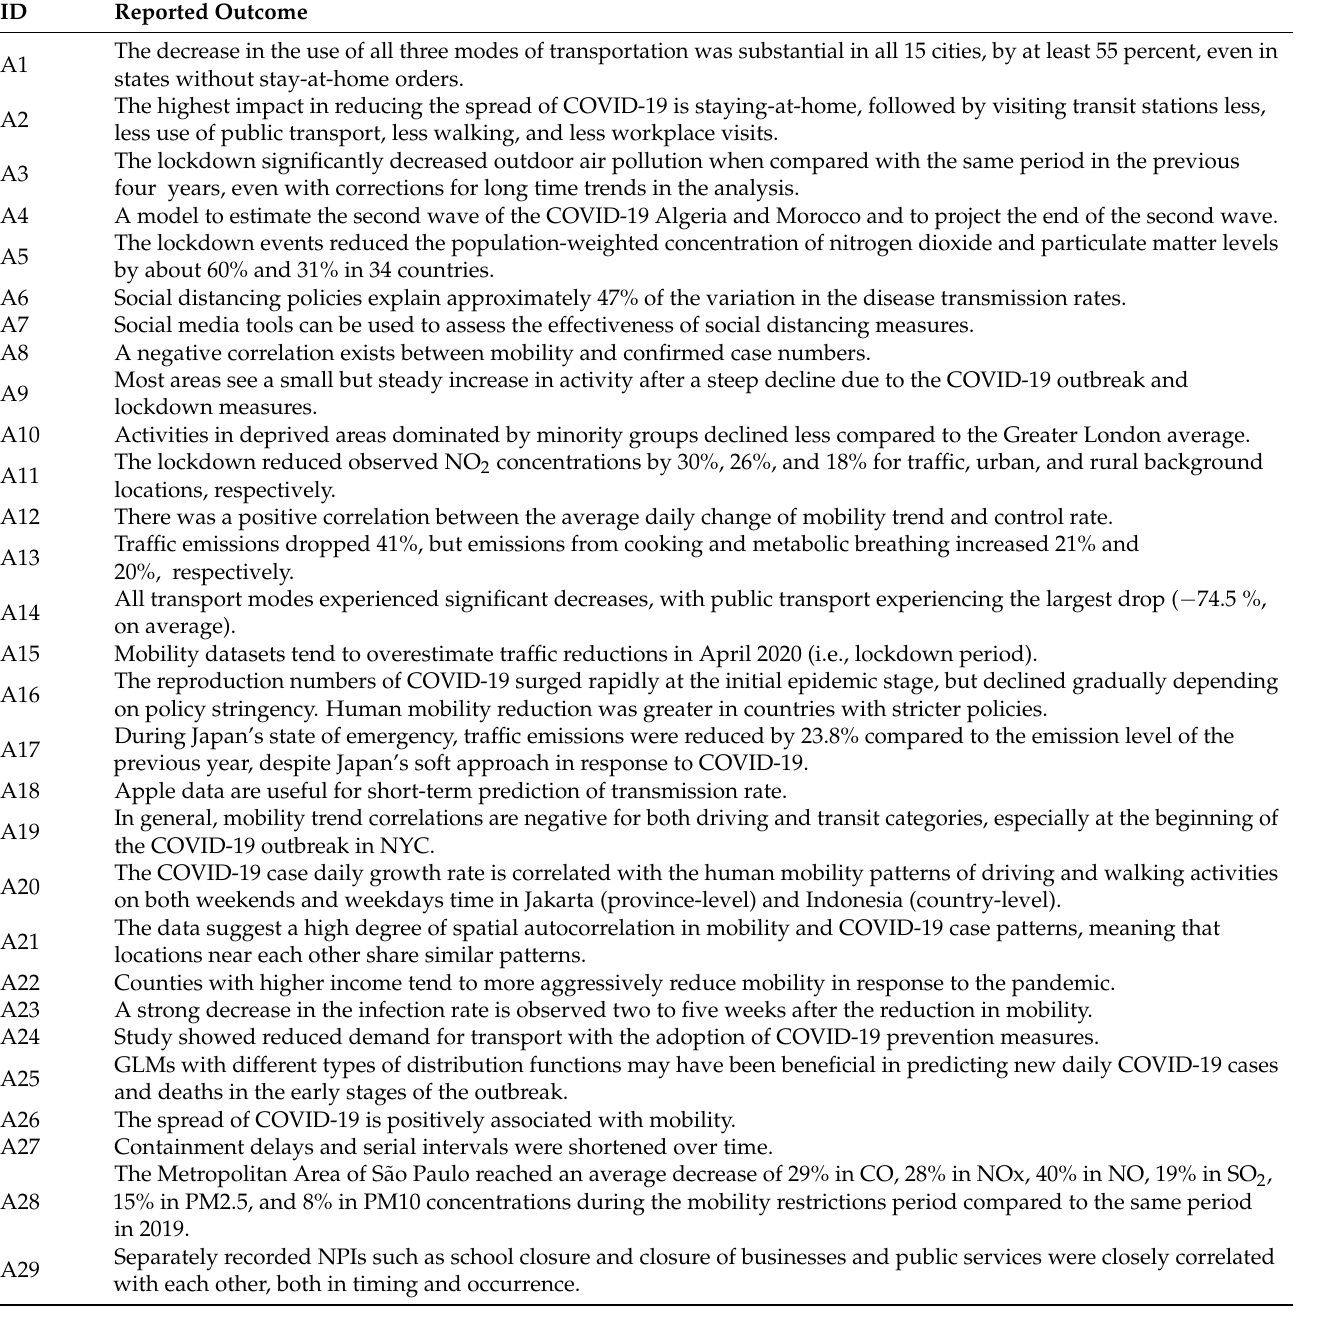
Table 4. List of the main reported outcomes reported in the reviewed